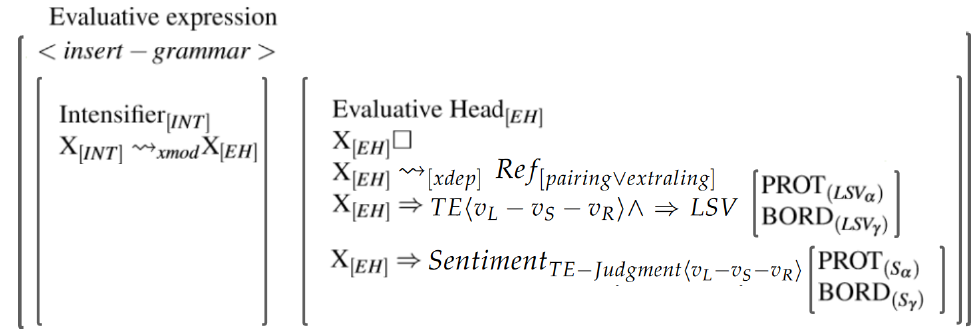
Figure 4. Universal construction of evaluative expressions (syntax and